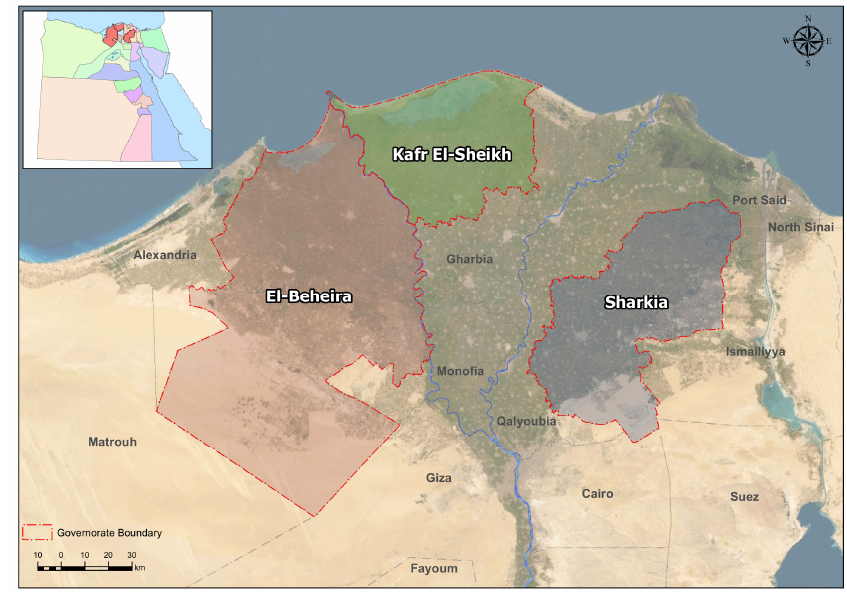
Figure 1. Study area in the Egyptian Nile Delta: Sharkia, El-Beheira, and Kafr El-Sheikh governorates. Source: Google